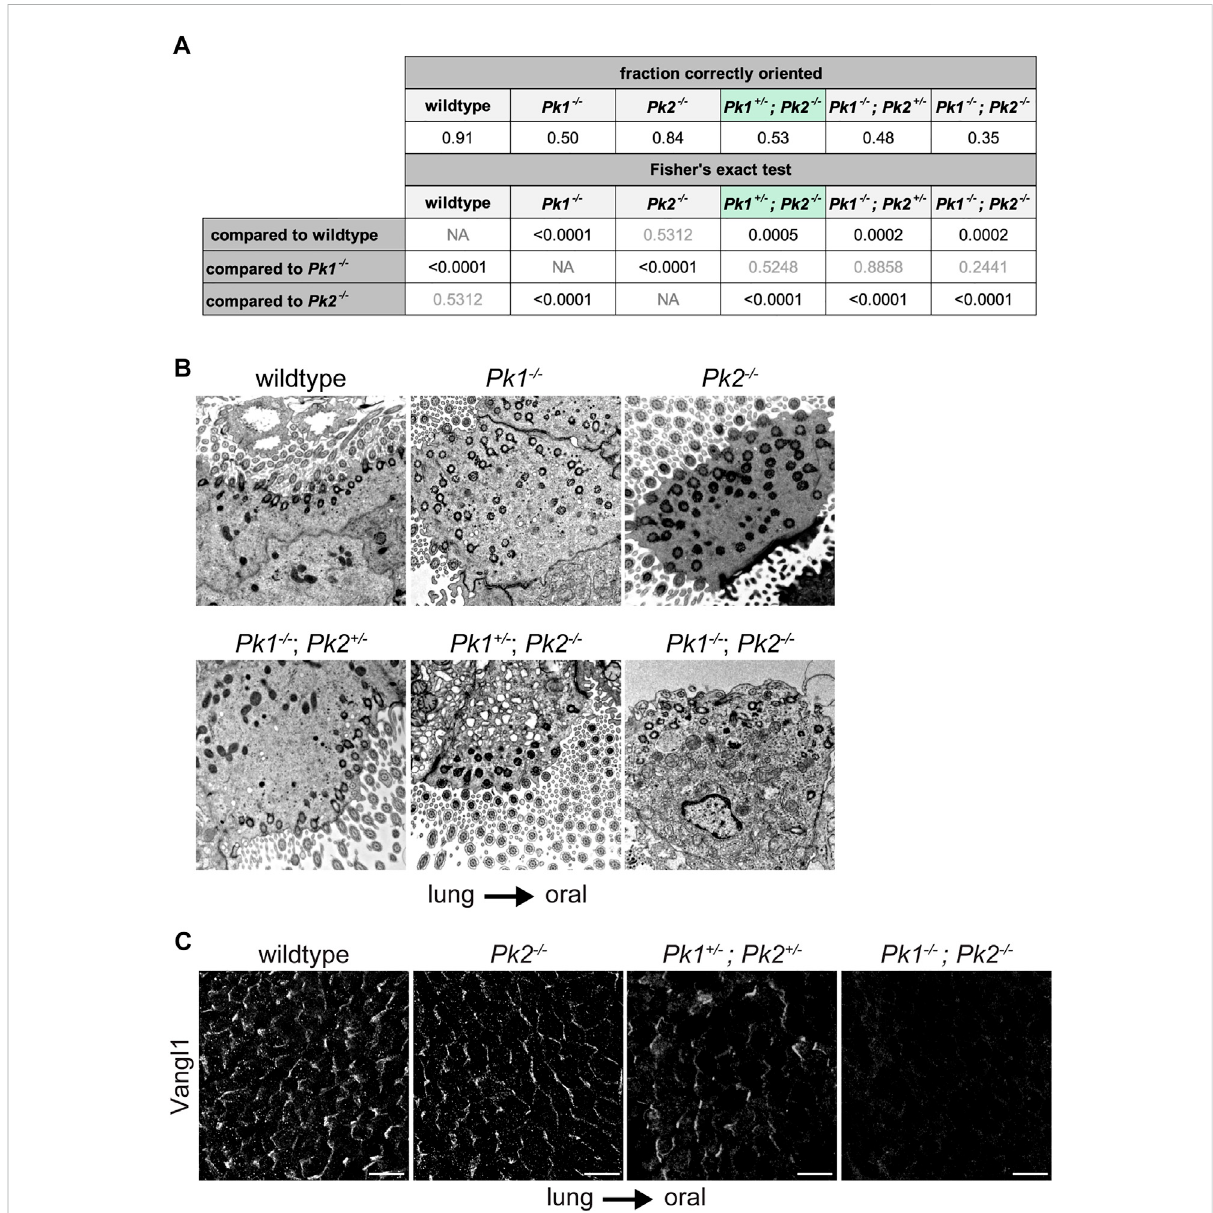
FIGURE 4 Basal body orientation in perinatal Pk mutant multiciliated cells. (A) . Basal body misorientation metrics in perinatal Pk mutants with appropriate statistics. Results from a Fisher ’ s exact test are shown in the table (left) as follows: statistically signi fi cant p -values are shown in black, nonsigni fi cant p -valuesare showningrey. Pk1 +/ − ; Pk2 − / − ishighlighted ingreen to indicate thatmice wereanalyzed atP16. (B) . Representative TEMimagesshowing basal foot orientation with respect to tissue axis. (C) . Maximum projections of confocal image stacks of wholemount immunolabeled